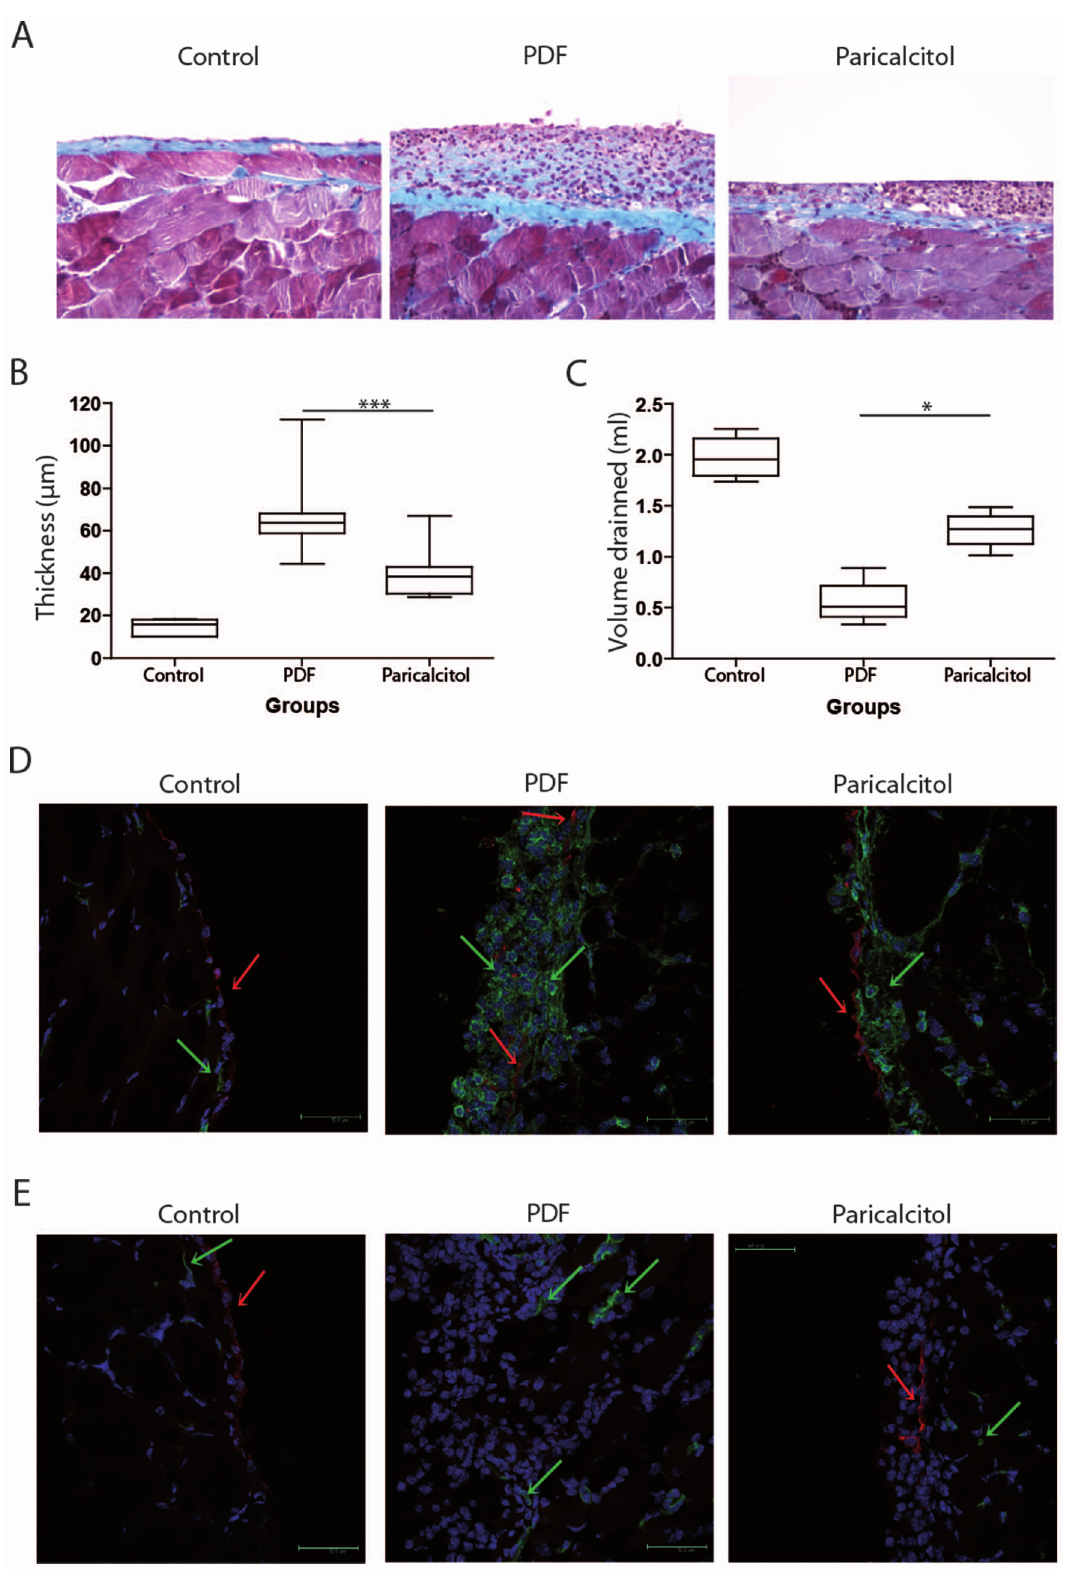
Figure 1. Paricalcitol reduced peritoneal membrane fibrosis, inflammation and ultrafiltration failure in mice exposed to PDF. A) Paraffin sections of the peritoneal membrane from the 3 groups were stained with Masson’s trichrome. B) Thickening of the peritoneal membrane was determined by morphometric analysis. C) Peritoneal permeability was determined by net ultrafiltration. D) The presence of inflammatory and mesothelial cells was determined by the expression of CD45 (green) and cytokeratin (red), respectively, in frozen sections of peritoneal membrane